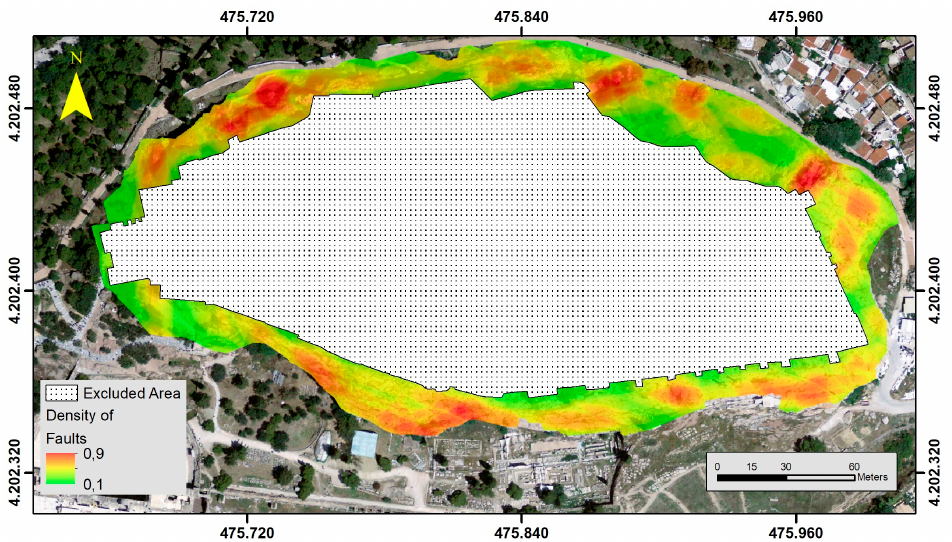
Figure 9. Instability related parameters (normalized): Density of Faults.